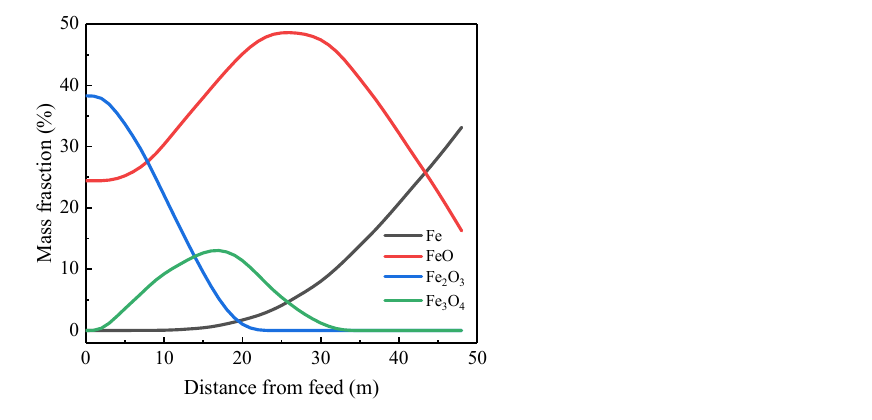
Figure 10. Average mass fraction of solid composition in the bed region along the axial section.